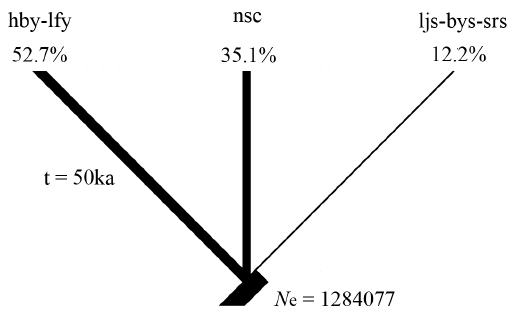
Figure 2. The model used to test the refugial hypotheses for S. ningshanensis using coalescent simulations. A single-refugium hypothesis concerning the refugia during the Dali glaciation (the last maximum glaciation in China which occurred about 50 ka before present) was tested. The detail interpretation for this model is given in the text. Branch lengths are time in generations based on a 6-year generation time in S . ningshanensis . Branch widths (effective population size, N e ) are scaled for each group based on the proportion of the total